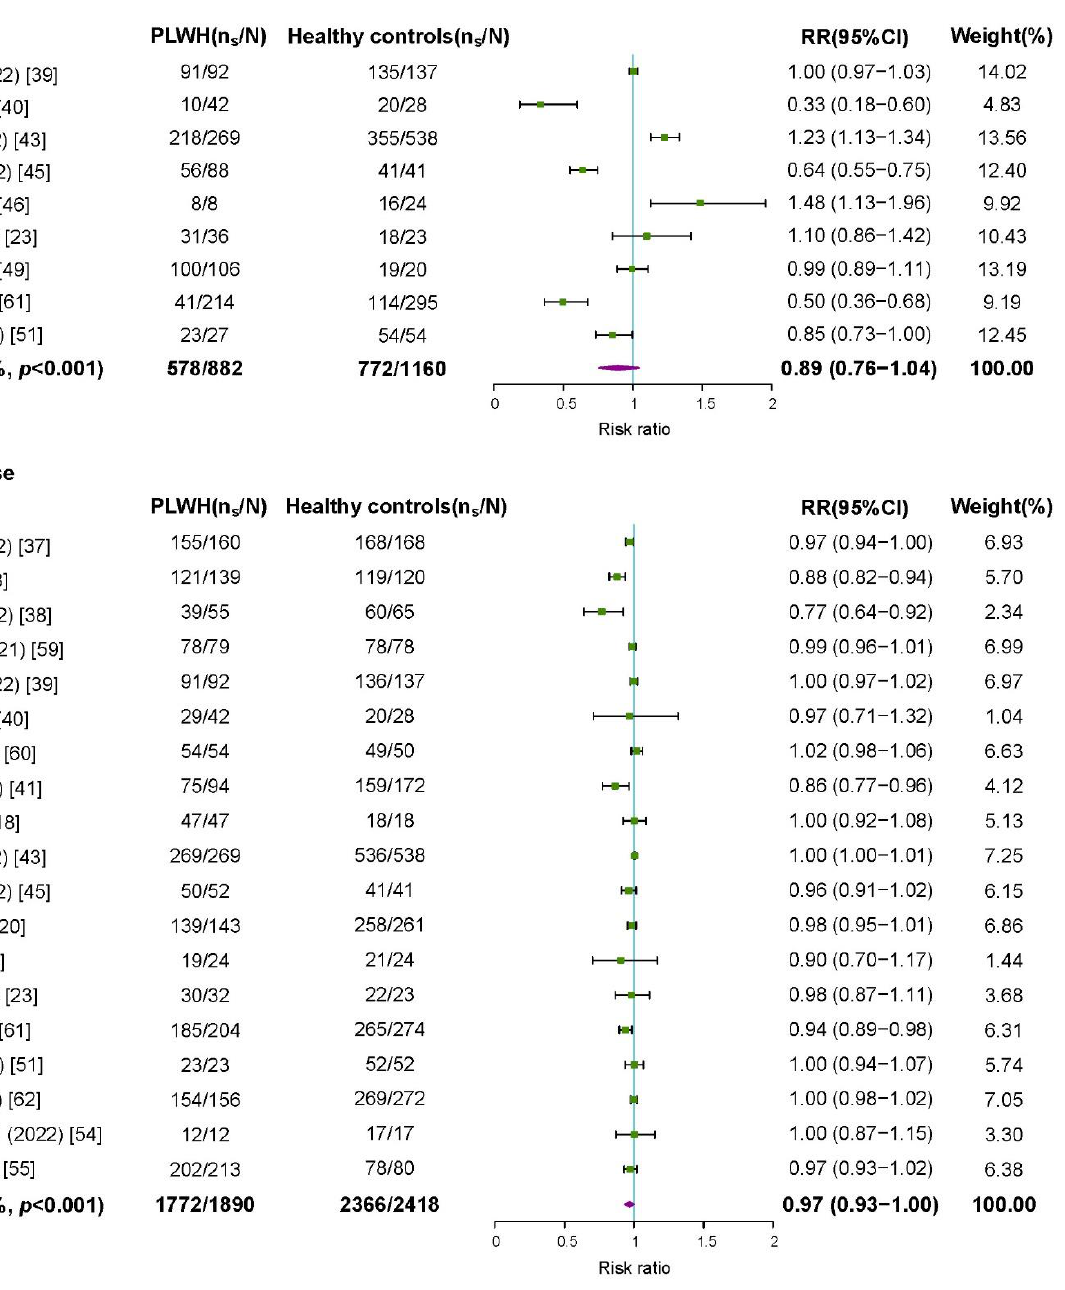
Figure 2. Risk ratios for seroconversion among people living with HIV compared with healthy controls after a first or second dose of COVID-19 vaccine. PLWH: people living with HIV; n s : number of people with seroconversion; N: group size; RR: risk ratio; CI: confidence interval. Table 2. Risk ratios for seroconversion among full-vaccinated people living with HIV compared with healthy controls by subgroup.